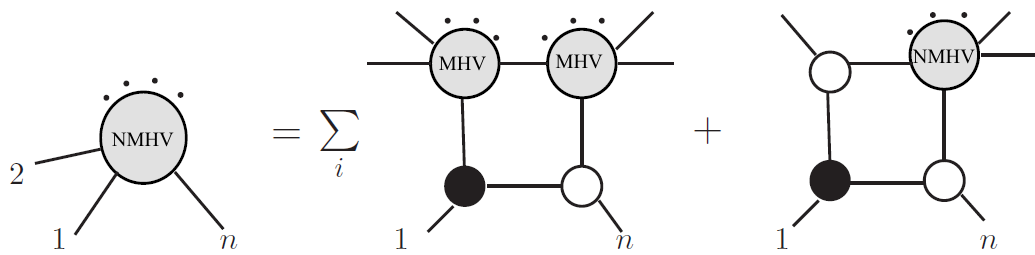
Figure 1 . The BCFW recursion relation in terms of on-shell graphs for an NMHV amplitude. The summation is performed over all possible MHV subamplitudes, where the index i denotes the rightmost external leg of the left MHV